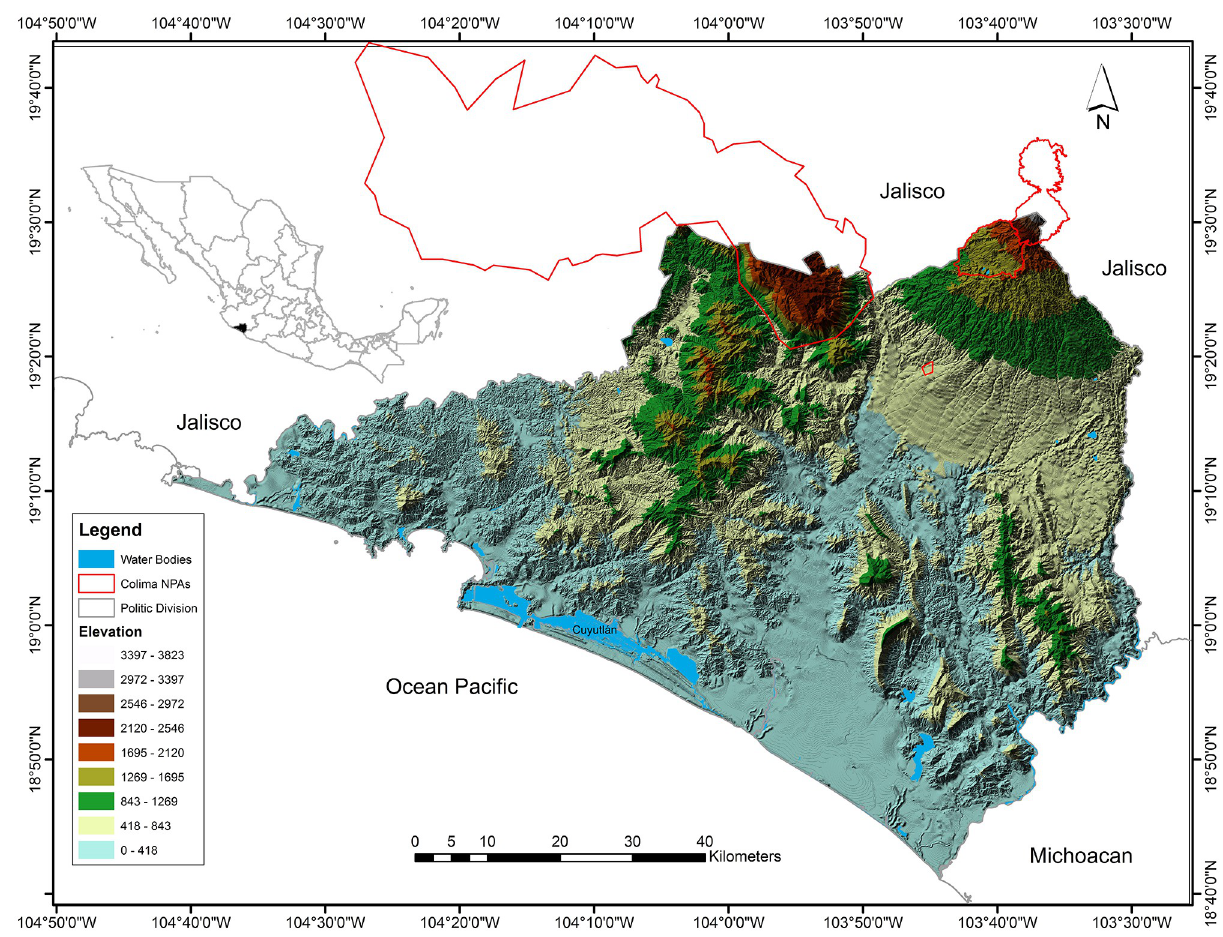
Fig 1. Location of the study area and Terrestrial Natural Protected Areas (NPAs) in Colima State, Mexico [35]. Maps were created by A.G. using ArcGIS ArcGIS 10.2.1. software (https://www.esri.com).